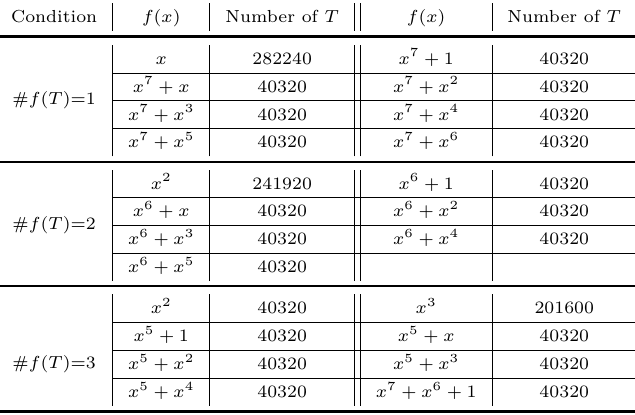
Table 2: Matrix polynomials on the 8 × 8 binary matrix polynomial residue rings Condition f ( x ) Number of T f ( x ) Number of